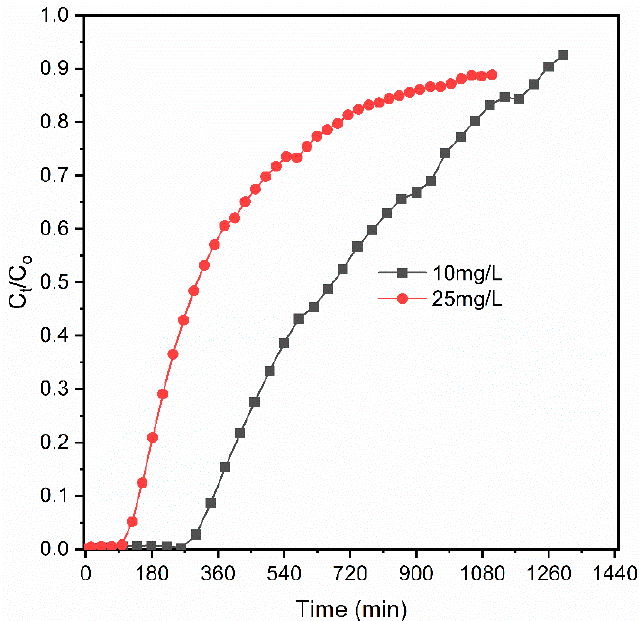
Figure 4. Effect of influent concentration on phosphate behaviors.